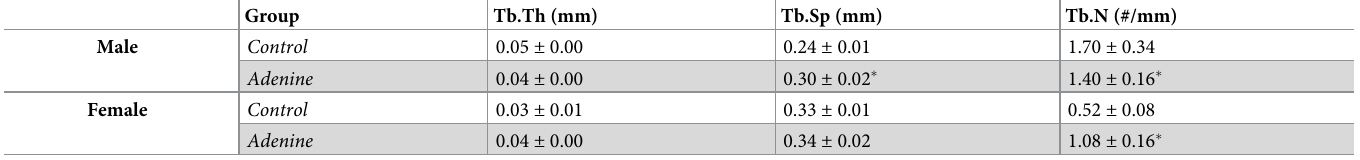
Data represented as mean ± standard deviation. � Indicates statistical difference (p < 0.05) from a t-test between control vs. adenine in each